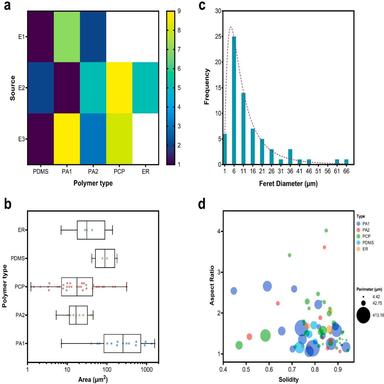
Distribution of detected MPs from the intravenous portion of the IV cannula. (a) A heatmap depicting the various polymer types of the MPs generated as a result of the presence of the catheter in Milli-Q water, along with their respective sources. Empty boxes indicate the absence of MP particles. (b) The distribution of individual polymer types resulting from the presence of the catheter in Milli-Q water, based on their respective two-dimensional orthogonal projection areas, is illustrated using a box and wh